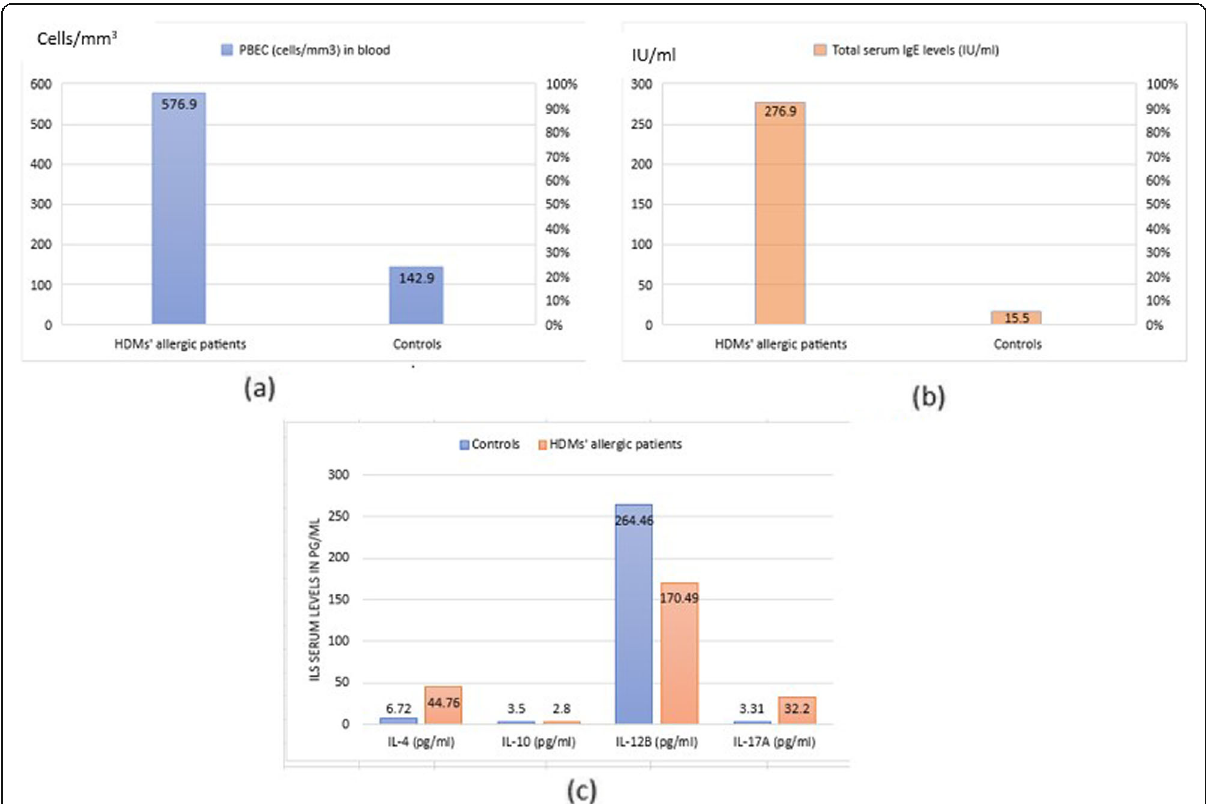
Fig. 3 a A graph comparing the total PBEC in patients and controls. b A graph comparing the total IgE levels in patients and controls. c A graph comparing IL4, 10, 12B, and 17A levels in patients and controls. All parameters represented as